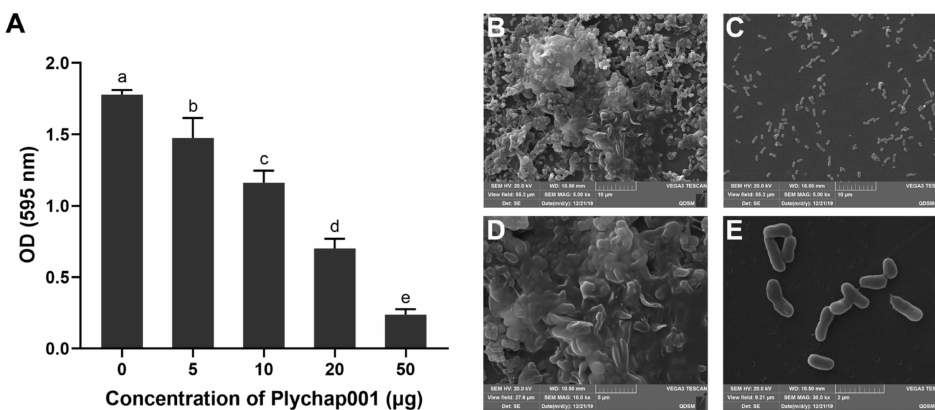
Figure 5. Antibacterial effect of Plychap001 on a mature V. parahaemolyticus 17802 biofilm. ( A ) Biofilm mass was determined using plating and crystal-violet staining methods. ( B , D ) SEM images of untreated V. parahaemolyticus biofilm. ( C , E ) SEM images of V. parahaemolyticus biofilm after treatment with 0.1 mg/mL Plychap001. Different letters (a–e) on the columns indicated significant difference between each other at p < 0.01 level. Data were shown as the mean ± SEM for n =